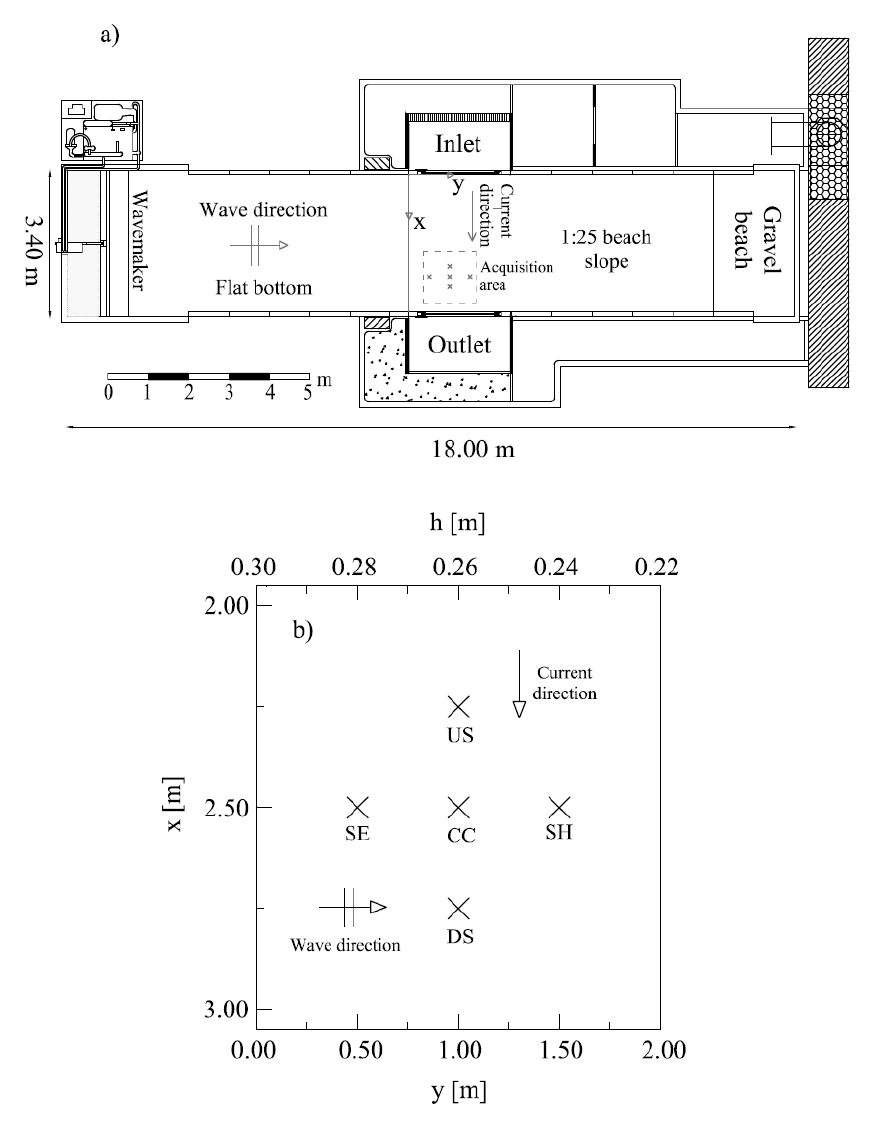
Figure 1. ( a ) Experimental tank for wave-current interaction; ( b ) top-view of the acquisition